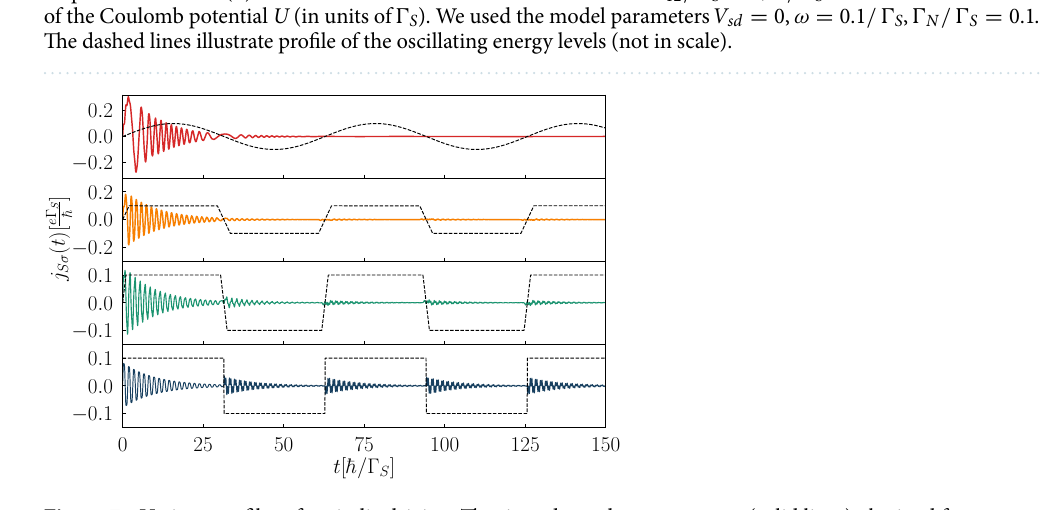
Figure 7. Various profiles of periodic driving. The time-dependent current j S σ (solid lines) obtained for several schemes of the periodic driving illustrated by dotted lines (not in scale). The results are obtained for 4 , A /Ŵ 2 , ω/Ŵ 0.1 , using the model parameters U V 12 /Ŵ S S = S = =